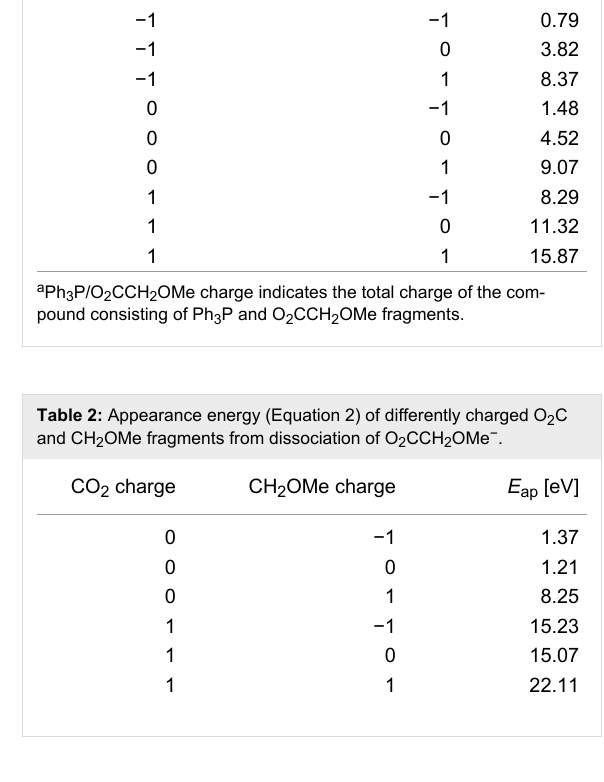
(Table 2). In summary, referring to the calculated data (Table 2), the most favorable fragmentation process,